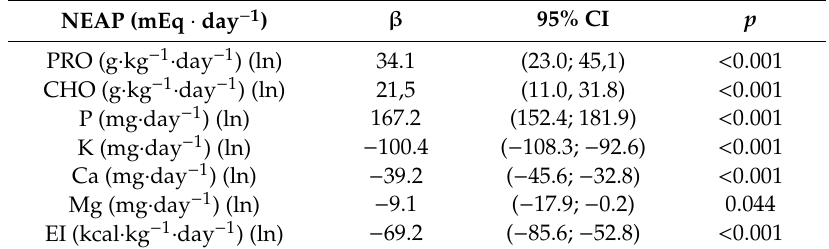
Table 5. E ff ects of carbohydrates, proteins, phosphorous, potassium, calcium, magnesium consumed by athletes on their net endogenous acid production